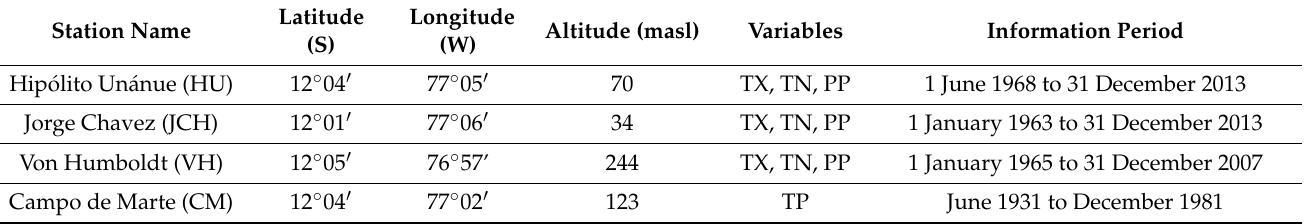
Table 1. List of climatological stations used in this study. Maximum temperature (TX), Minimum temperature (TN), average temperature (TP), and precipitation